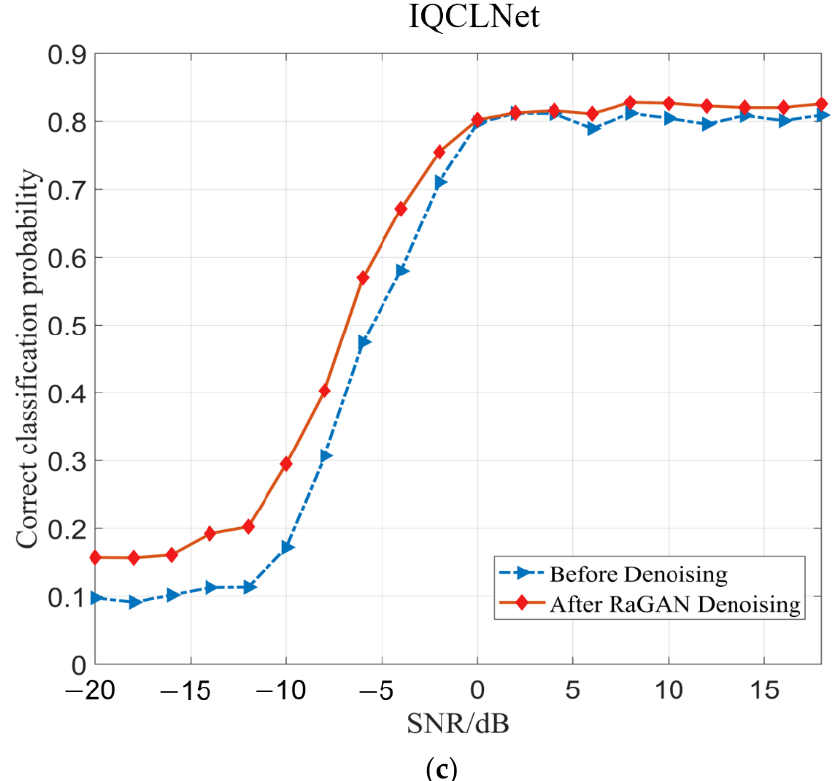
Figure 7. Comparison of recognition rate before and after RaGAN noise reduction: ( a ) CNN2 recognition comparison; ( b ) IQCNet recognition comparison; ( c ) IQCLNet recognition comparison.